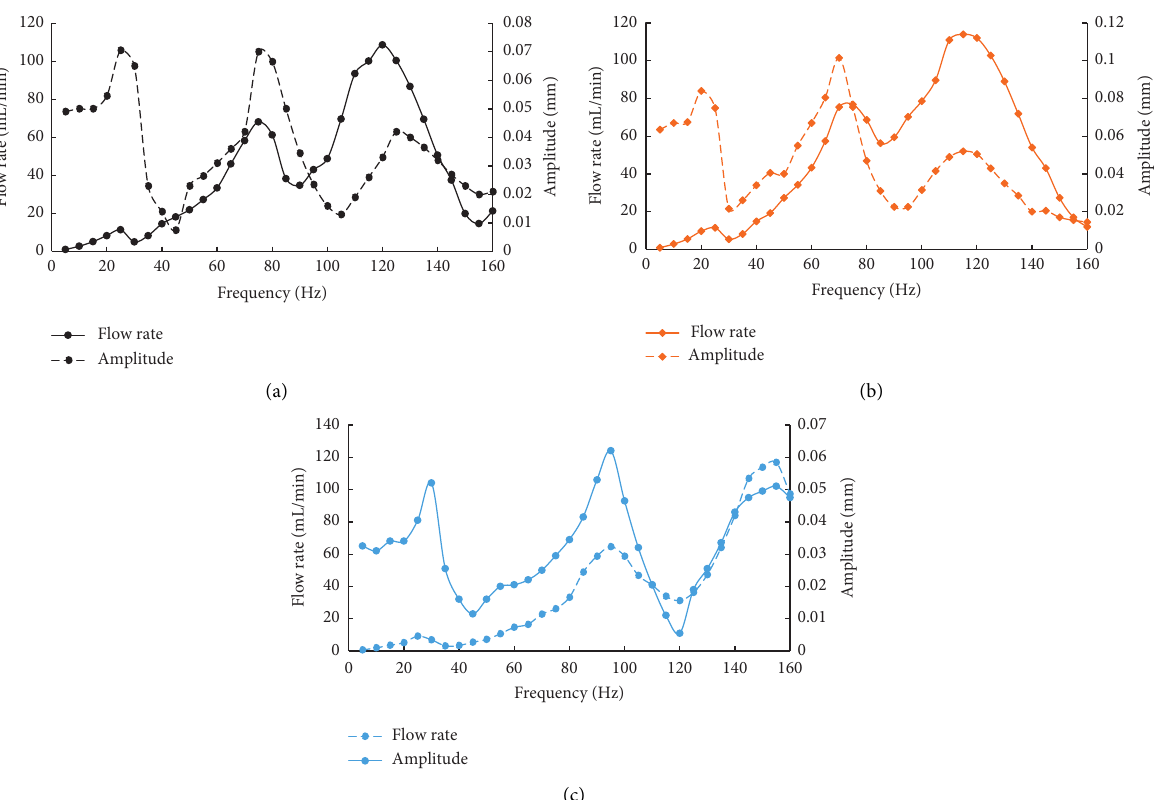
Figure 8: The comparison of amplitude and flow with frequency: (a) pump A; (b) pump B; (c) pump